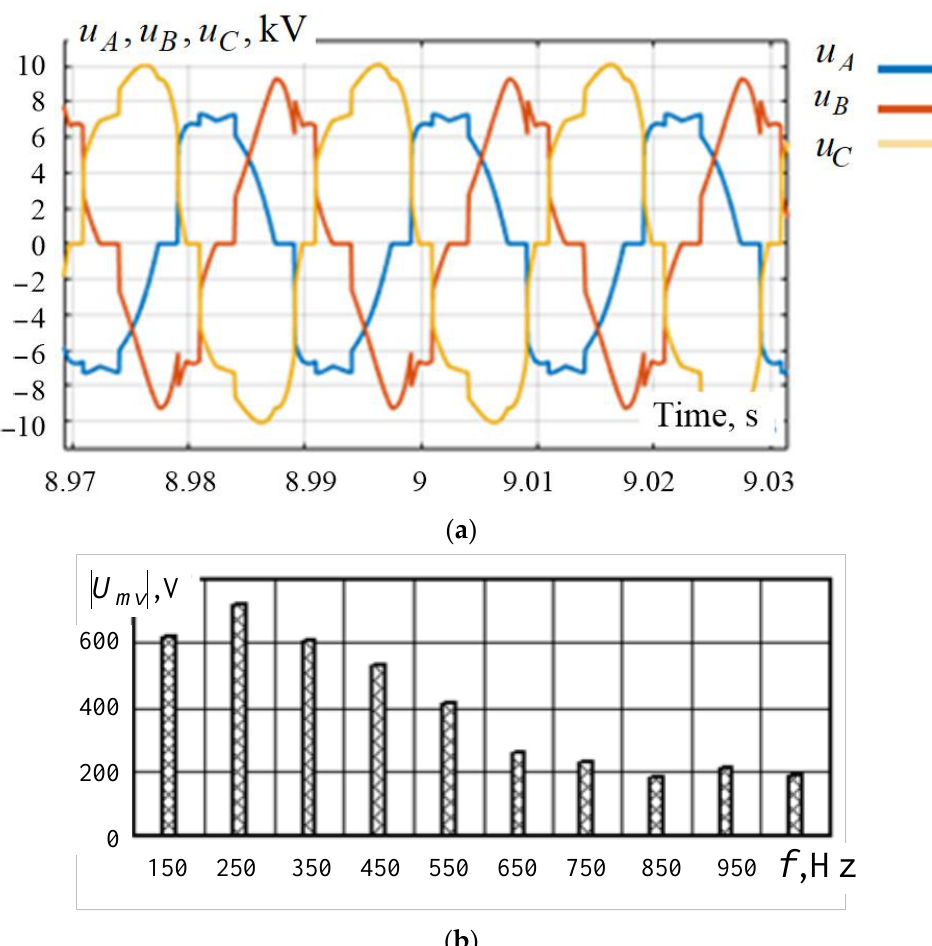
Figure 22 . The waveform of generator stator voltages ( a ) and its harmonic content ( b ) when feeding a non-linear unbalanced load.